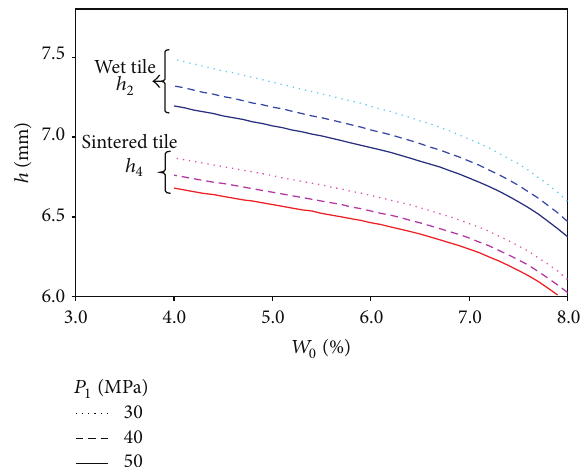
Figure 14: Influence of powder moisture ( 𝑊 0 ) and pressing pressure ( 𝑃 1 ) on tile thickness ( ℎ